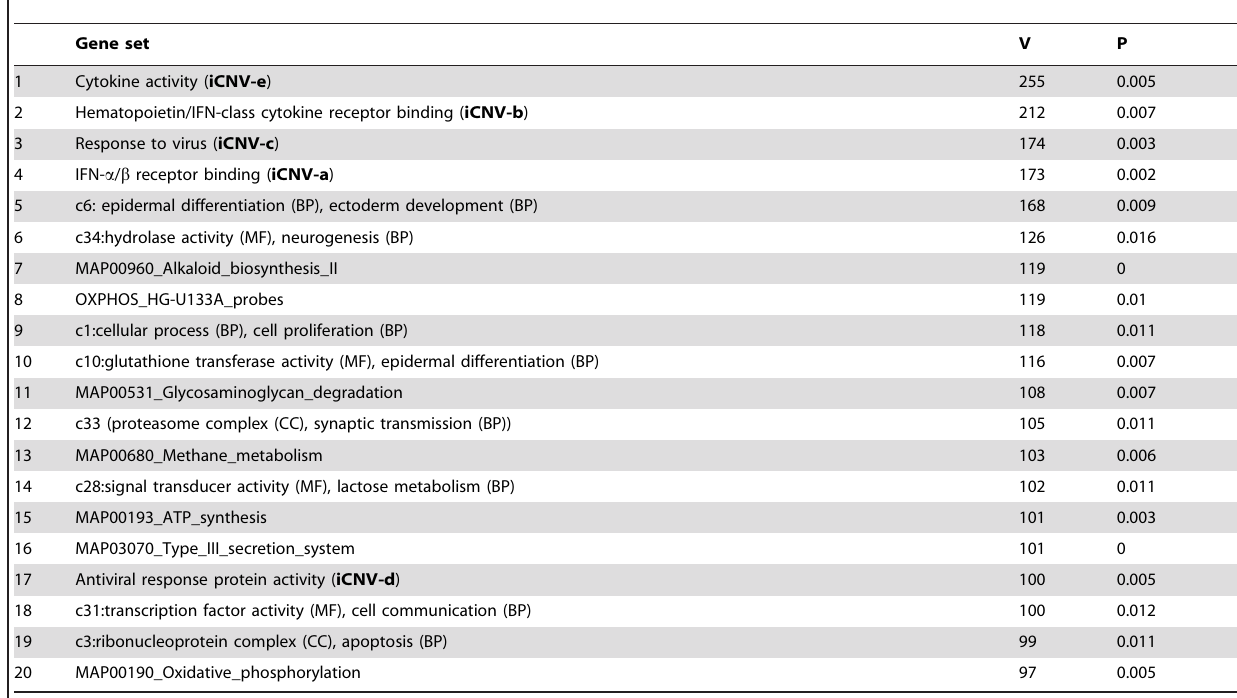
Table 2. LoGS on autism loci. Shown are the top 20 pathways.